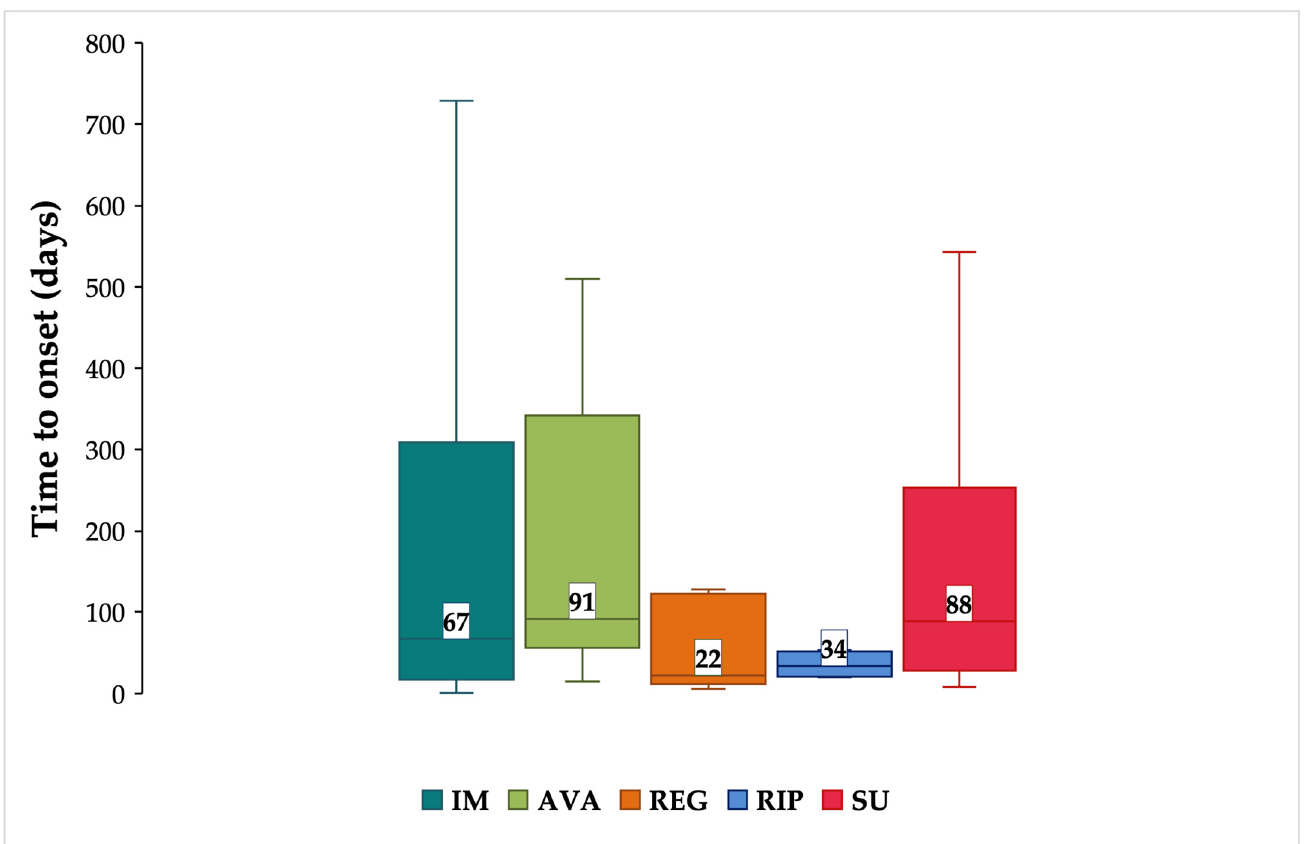
Figure 3. Time to onset of neuropsychiatric ADRs. Data are reported as box plots with the box drawn from Q1 to Q3 and the horizontal line drawn in the middle to denote the median. Abbreviations: AVA = avapritinib; IM = imatinib; REG = regorafenib; RIP = ripretinib; SU = sunitinib. Considering the probability of reporting neuropsychiatric ADRs, AVA was related to a higher reporting probability compared to all other TKIs: in detail, Psychiatric disor- ders (ROR 6.36; CI 95% 5.15–7.84) and Nervous system disorders (4.63; 3.99–5.37). Most neuropsychiatric ADRs by HLT with a higher probability of reporting when AVA was the suspected TKI were already known as common in the SmPC except for lumbar spinal cord and nerve root disorders intended as sciatica (ROR 4.46; CI 95% 1.58–12.54), olfactory nerve disorders, including anosmia and parosmia (8.02; 2.44–26.33), and hallucinations